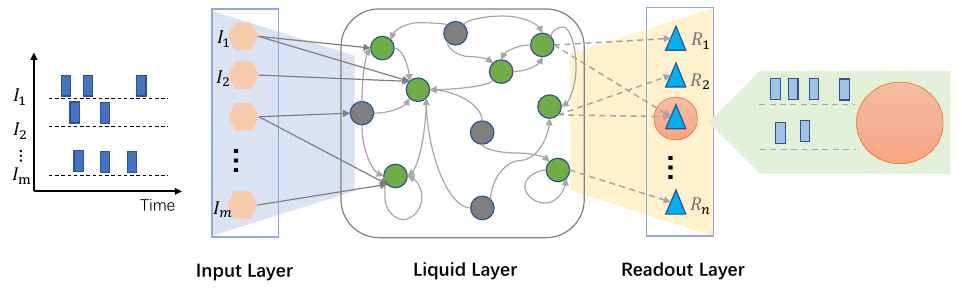
Figure 1. The structure of